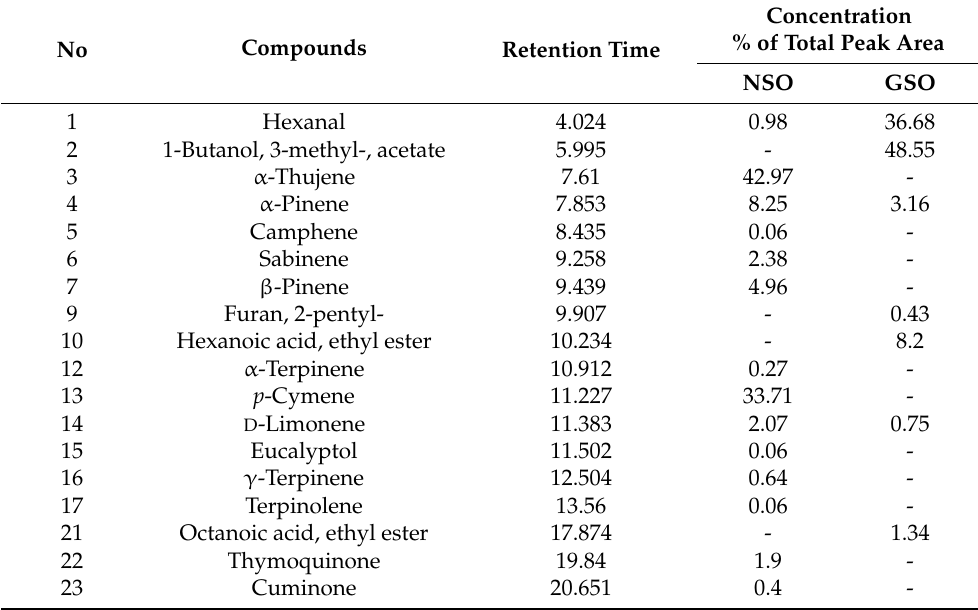
Table 3. Gas chromatography coupled with mass spectroscopy (GS–MS) chemical composition of volatile compounds identified in NSO and